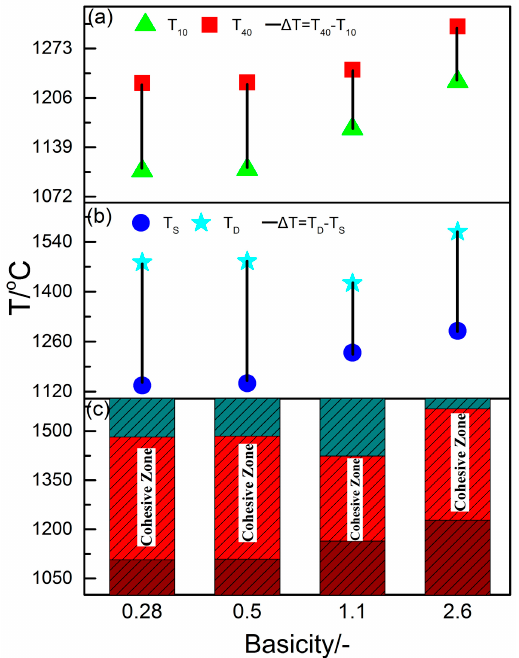
Figure 11. Softening-melting-dripping properties of acid, self-fluxing, and high-basicity PVTM sinters. ( a ) Softrning zone; ( b ) Melring-dripping zone; ( c ) Cohesive zone.